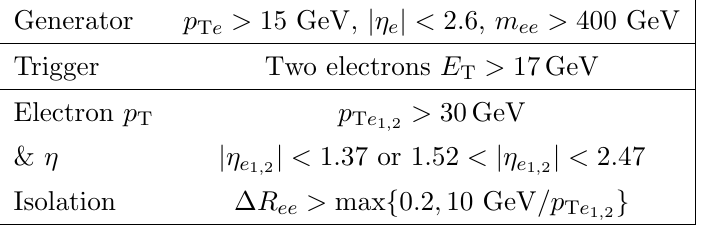
e + e (cid:0) ! = 1 : 5 TeV and (cid:21) (cid:30) = eu eu